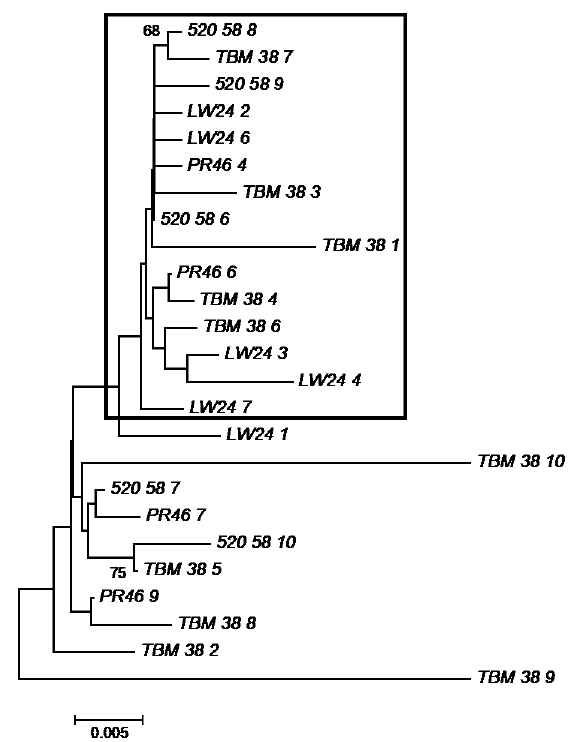
Figure 5. Neighbor Joining tree of sxtA4 sequences obtained from clones of single cells of P. bahamense from the representative sampling sites. Percentages from the bootstrap test (500 replicates) are shown next to the branches. The Tamura 3-parameter method best fit the data and so was used to compute the evolutionary distances. Twenty-five nucleotide sequences were included in the analysis. All ambiguous positions were removed for each sequence pair. There were a total of 517 positions in the final dataset. Evolutionary analyses were conducted in MEGA7. Nomenclature is as follows: Sampling site_cell_clone number. Note that for each site, the “cell” number is the same, as all sequences from that site were derived from the same cell. DB = Diamond Bay (IRL); TBM = Telemar Bay Marina (IRL); LW = Lee Wenner Park (IRL); 520 = 520 Bridge (IRL); PR = Mosquito Bay in Puerto Rico. Sequences with the 15 bp deletion are boxed.